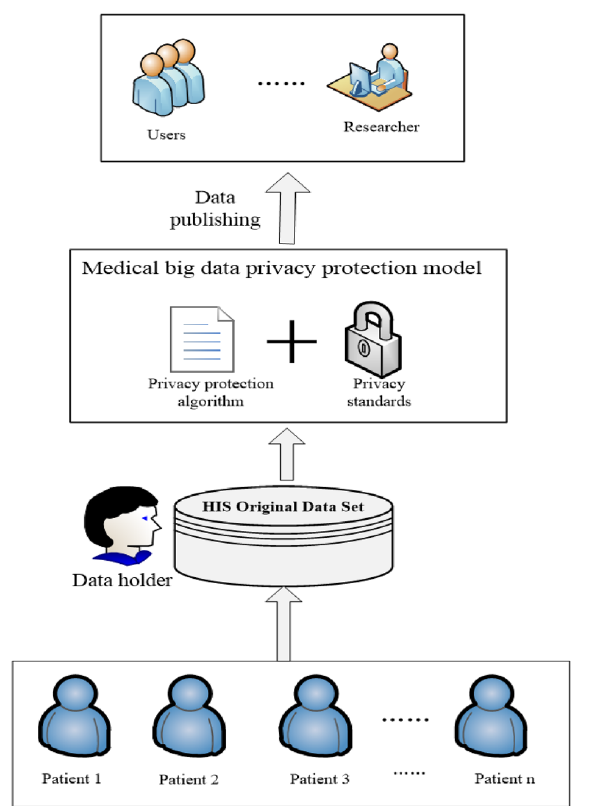
Figure 1. Medical big data privacy protection